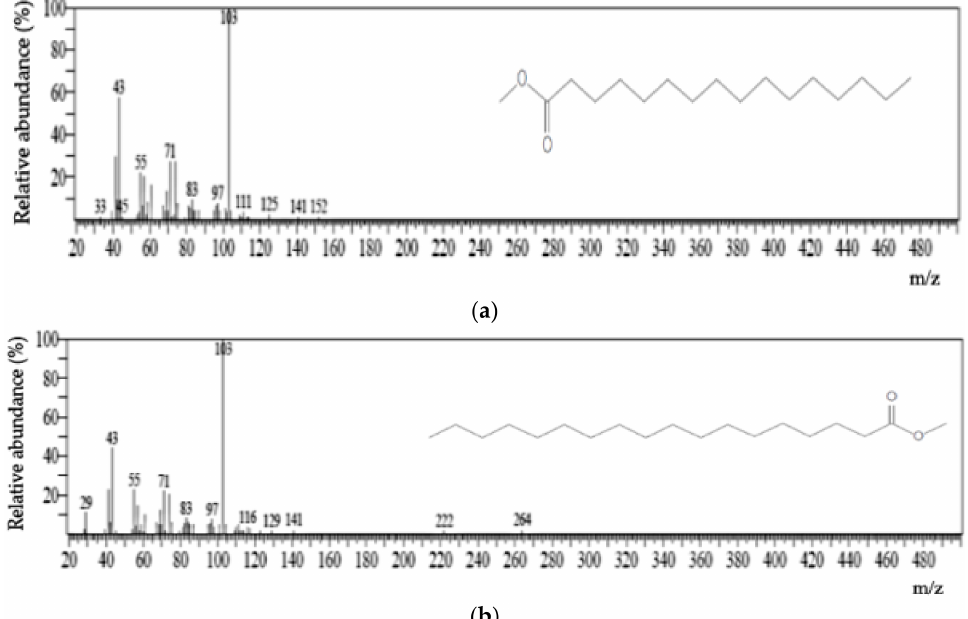
Figure 2. GC ionization mass spectra of the two monomeric components of the PHA produced by the bacterium ( Acinetobacter sp. Strain AAAID-1.5), ( a ): 3-hydroxyhexanoate methyl ester, ( b ): 3- hydroxyoctanoate methyl